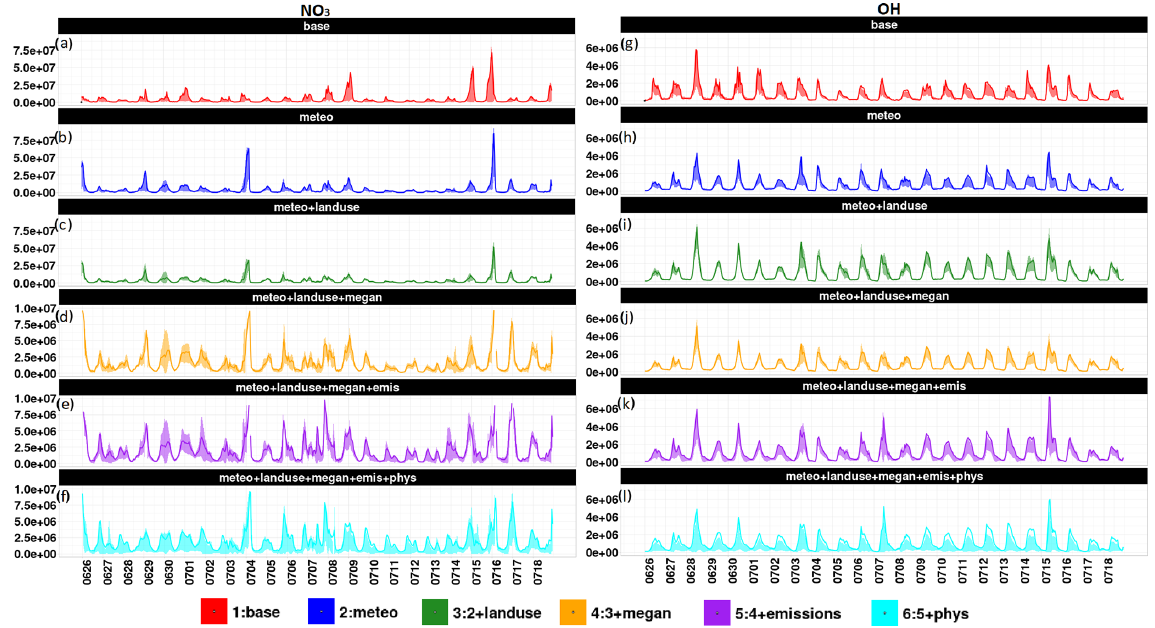
Figure 8. Time series for OH and NO 3 concentrations (both in ppb) for all of the sensitivity cases explained above. The color schemes are shown at the bottom. The name of each case is written above each time series. Note that the NO 3 columns have two different scales because of visibility issues. Both plots use the same units (moleculescm − 3 s − 1 ), but the scale for NO 3 changes for certain test